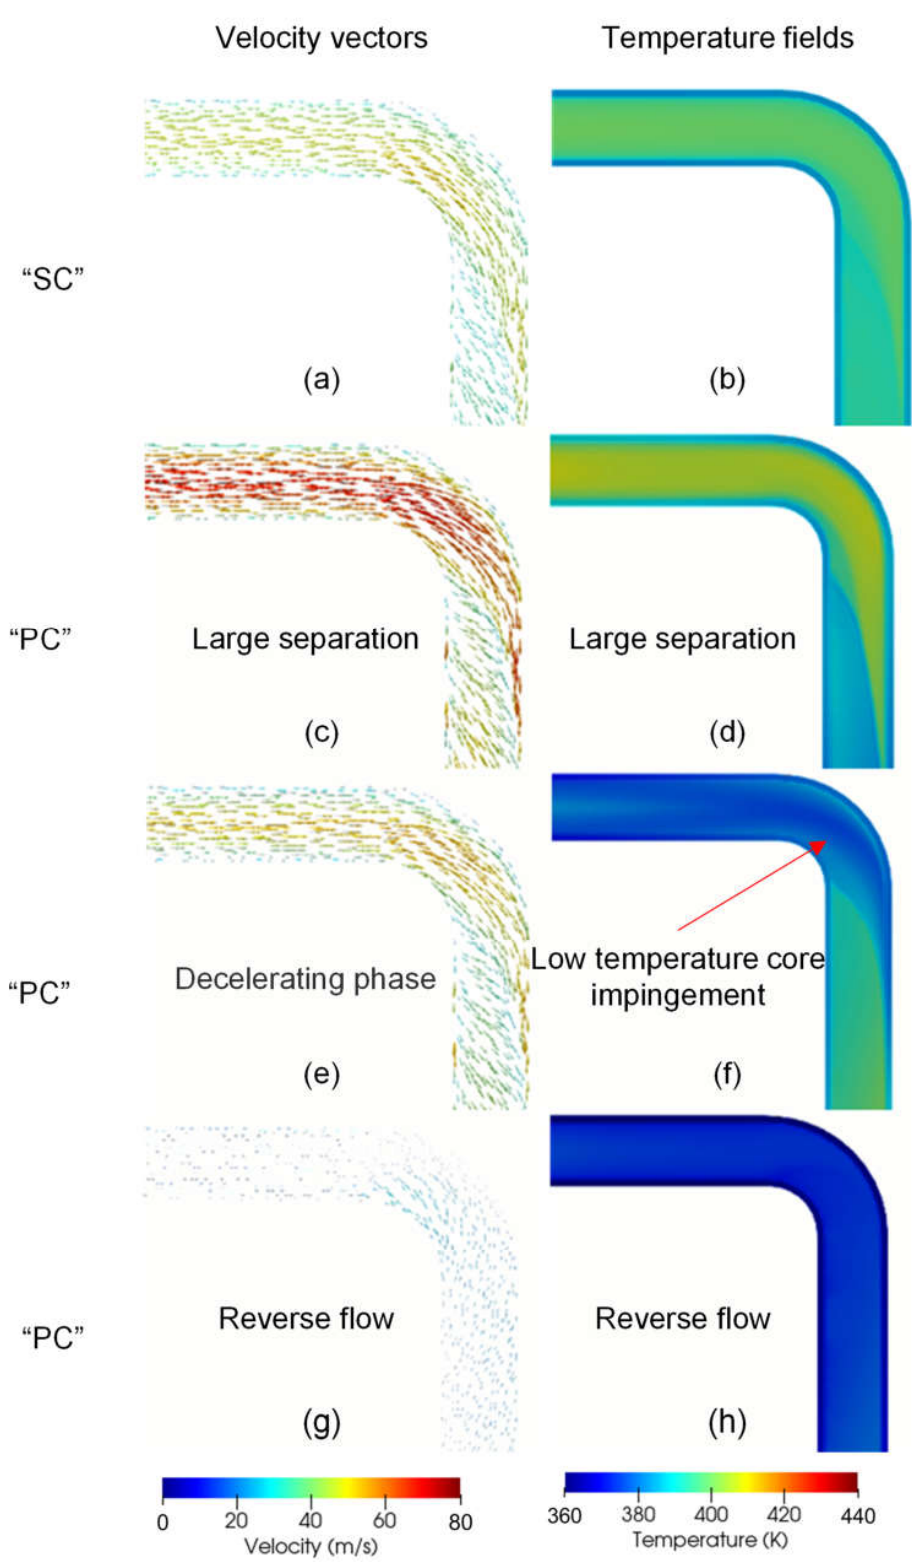
Figure 18. Instantaneous velocity vectors and temperature fields of the horizontal section along the center axis of the curved pipe in the simulation: ( a ) and ( b ) are results of the steady flow, ( c ) and ( d ) are the results of the deceleration phase of the pulsating flow, ( e ) and ( f ) are results of the pulsating flow approaching the minimum velocity, ( g , h ) are results of the reverse